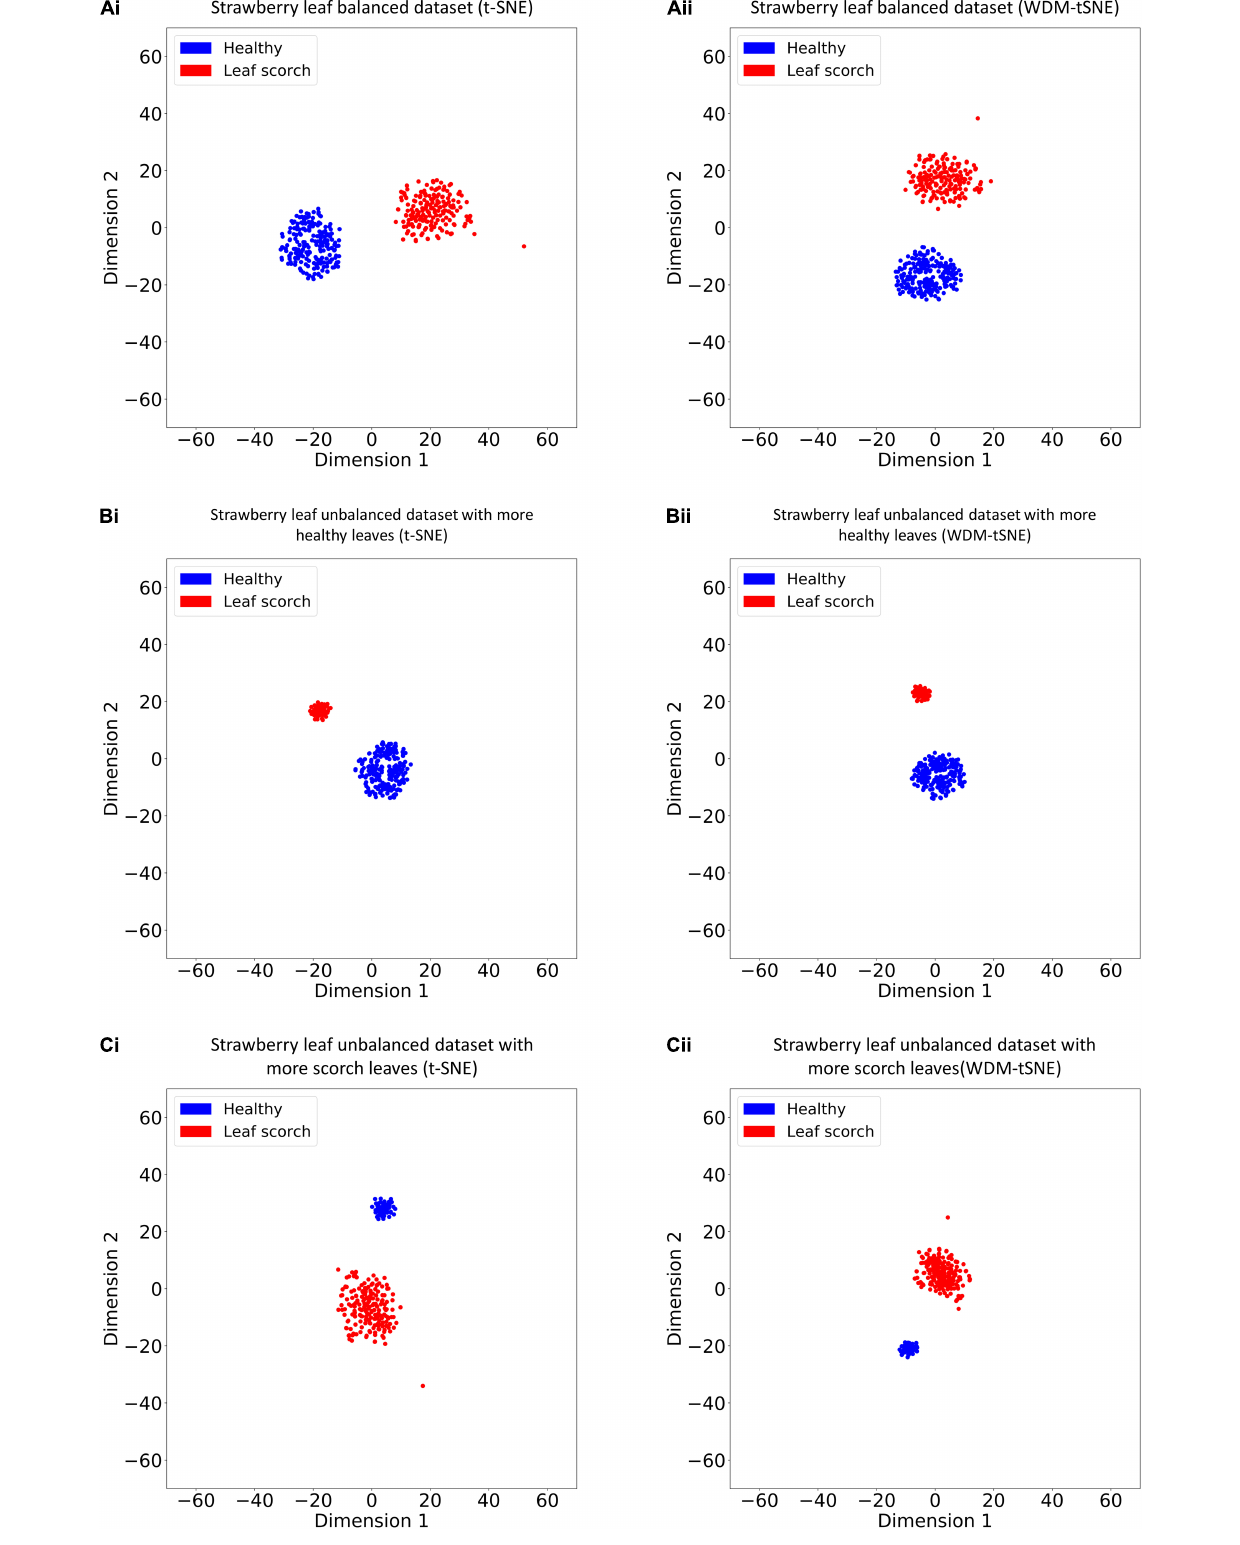
Frontiers in Plant Science |